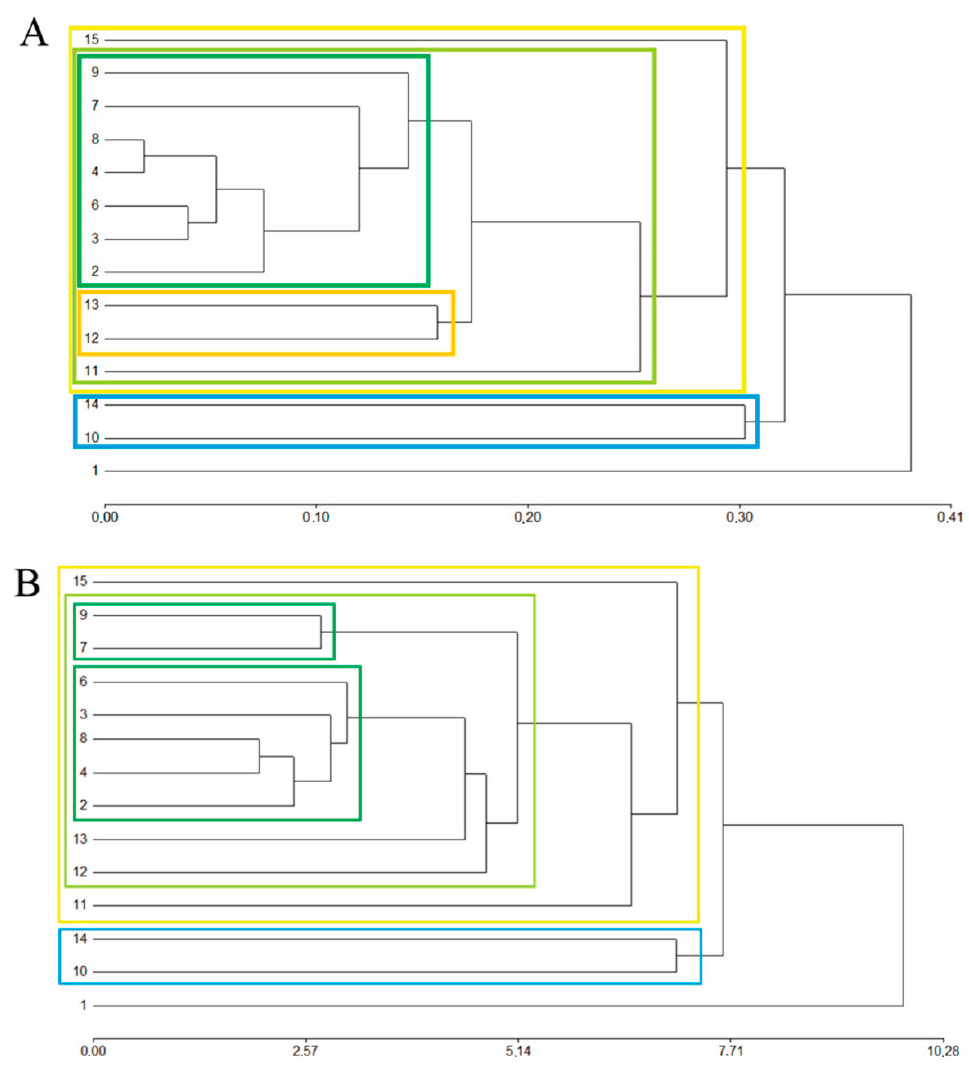
Figure 3. Dendrogram of agglomerative hierarchical clustering of sites according to: ( A ) Phytophthora spp. abundance (number of reads for each matched species) data matrix using Bray-Curtis similarity index and Ward clustering method; ( B ) Phytophthora spp. presence/absence data matrix using Euclidean distance index and average linkage clustering method.